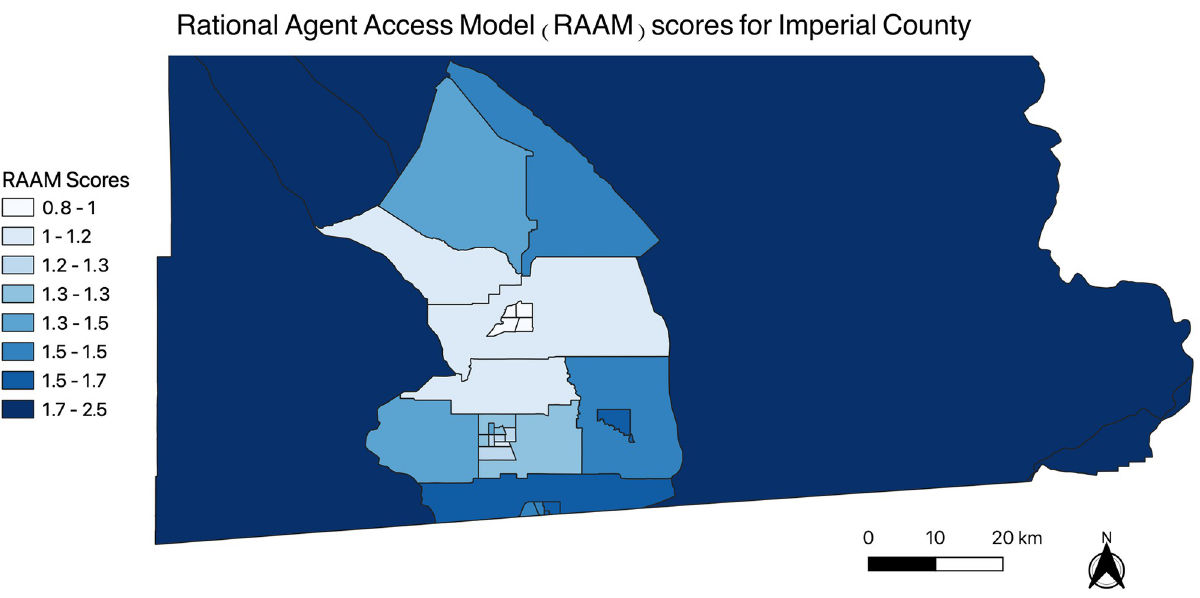
Fig 4. Map of Rational Agent Access Model (RAAM) scores for Imperial County 2010 shapefile census tracts. The map was generated using the free and open-source software QGIS version 3.14 (http://www.qgis.org/en/site/about/index.html).